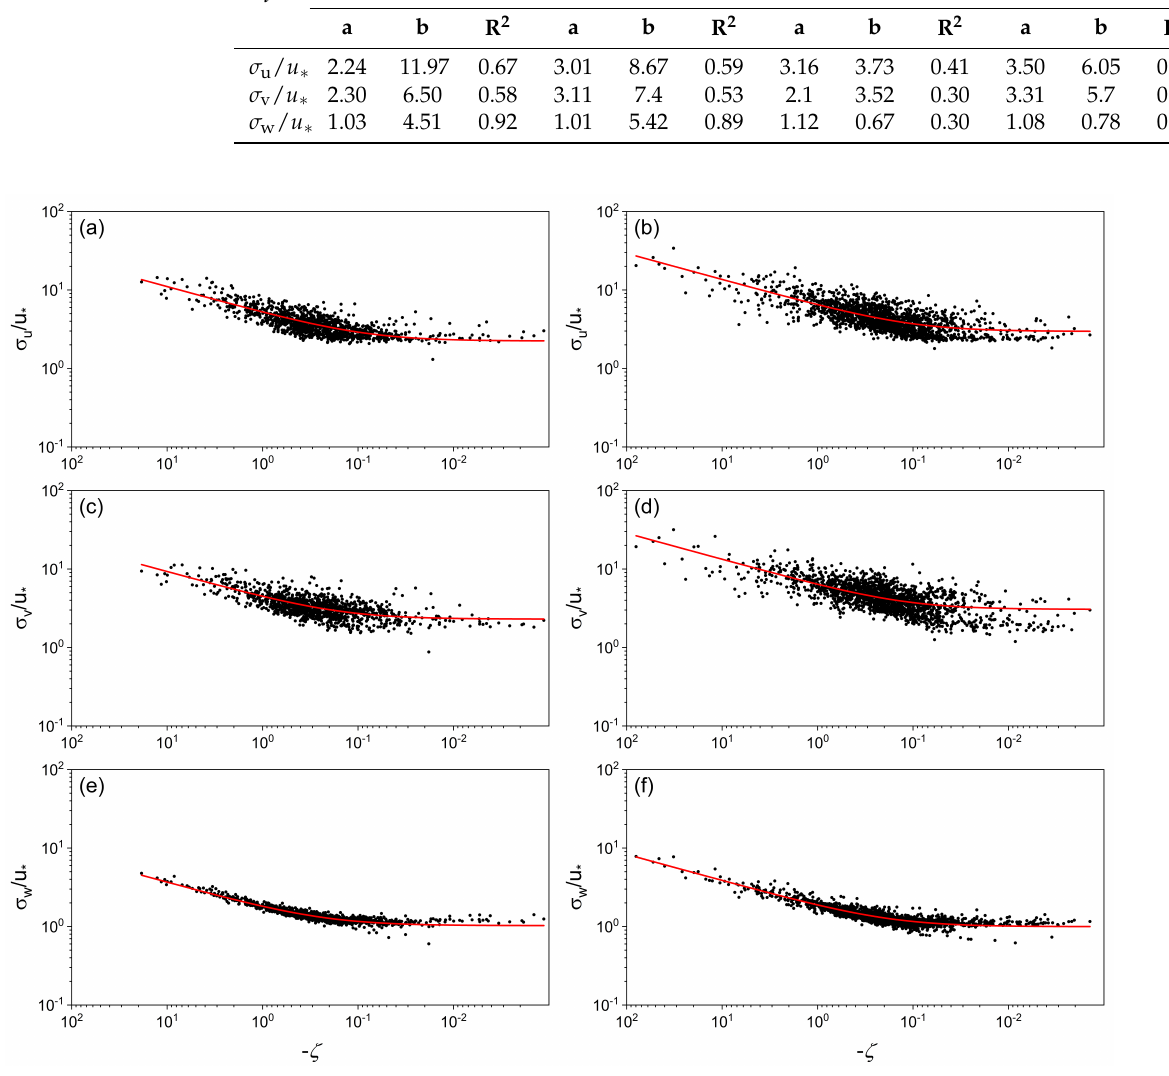
Figure 1. Cont . Figure 9. Normalized standard deviation of longitudinal wind velocity ( σ u / u ∗ ), lateral wind velocity ( σ v / u ∗ ), and vertical wind velocity σ w / u ∗ for unstable stratification conditions at the PV plant (left: ( a , c , e )) and the reference site (right: ( b , d , f )) from June to October 2019. The red solid line represents the empirical relations applied to the observed data.